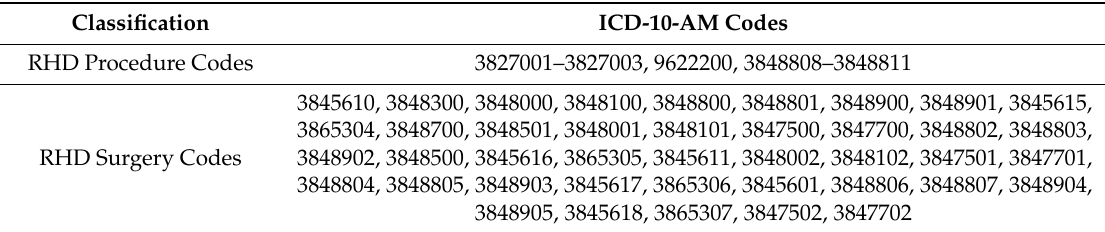
Table A1. ICD-AM-10 codes for procedures and surgeries related to